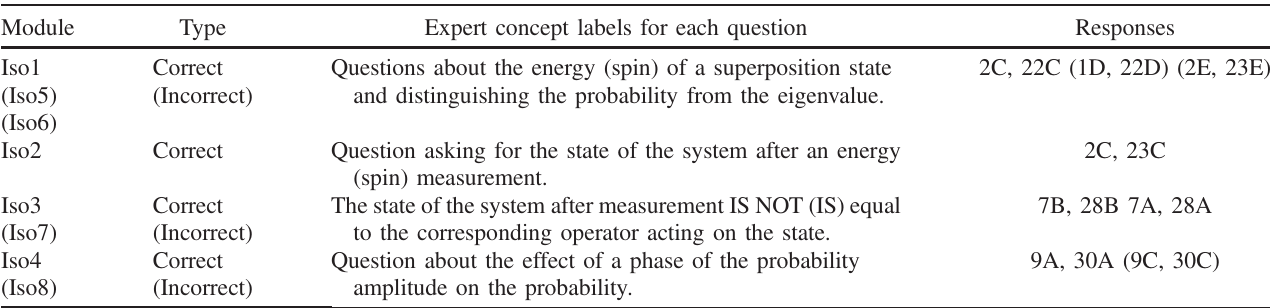
TABLE III. Modules identified in the QMCA that consist of isomorphic items. The modules are labeled as in Fig. 3. The expert interpretation of each module is also